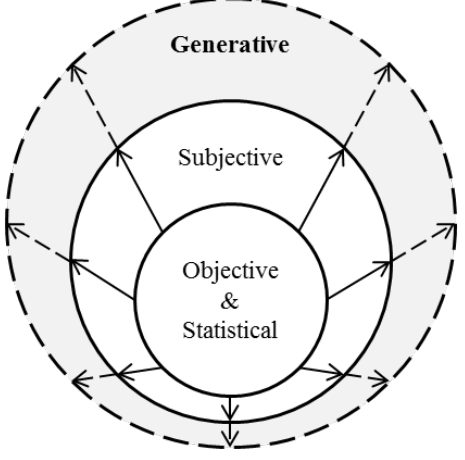
Fig. 1. Three fields of decision-making Two complementary